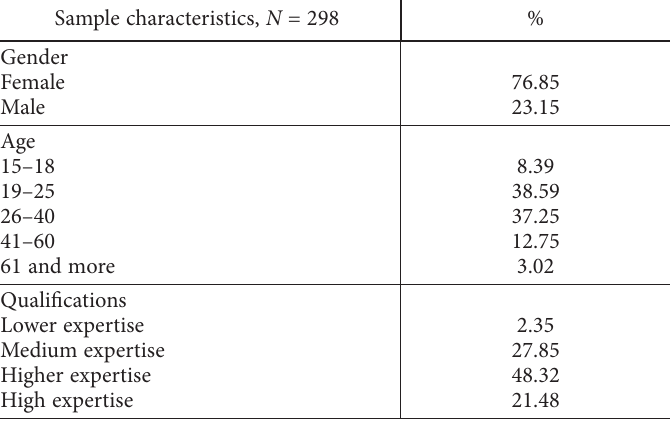
Table 1. Sociodemographic characteristics of respondents (source: prepared by authors) Sample characteristics, N = 298